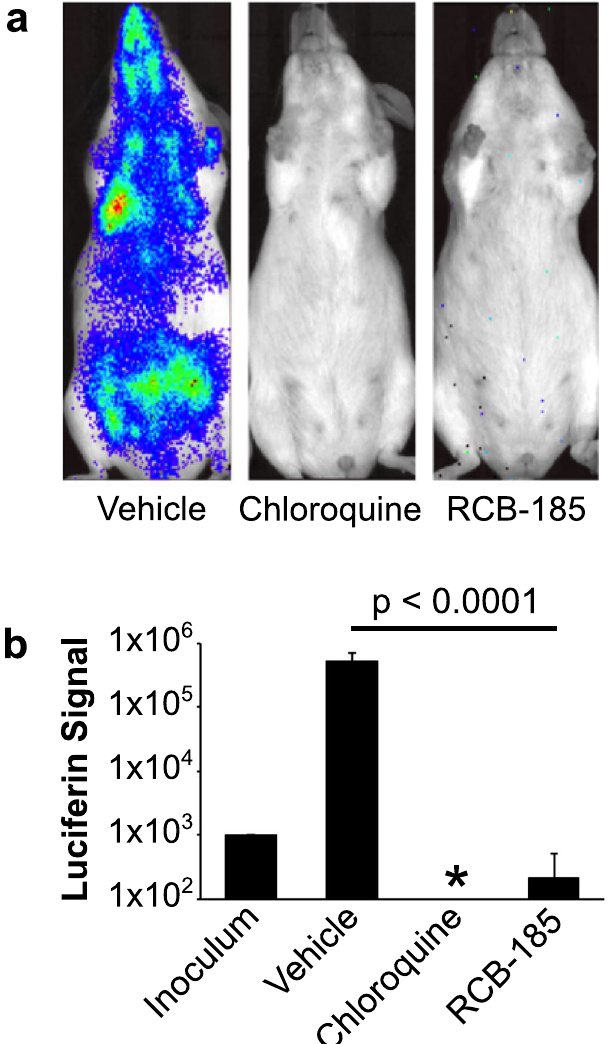
Figure 6. RCB-185 is efficacious in a mouse model of malaria. Groups of 5-7 Swiss Webster mice were infected with 10 3 P. berghei ANKA expressing luciferase via i.p. injection. On days 2–7, mice were dosed once per day with vehicle, 20 mg/kg chloroquine, or 50 mg/kg RCB-185. At 7 days post-infection, mice were imaged with an IVIS imager and the parasite burden quantified by luciferase signal intensity. Representative images are shown for each treatment condition (top), and the average luciferase signal intensity quantified for each treatment (bottom). Displayed are the means ± SD for each treatment group. The asterisk indicates the luciferase signal was below the limit of